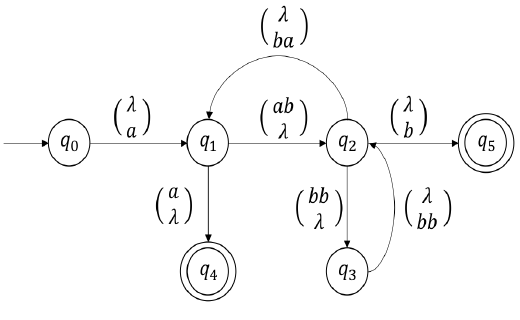
Figure 1. A simple Watson-Crick finite automata